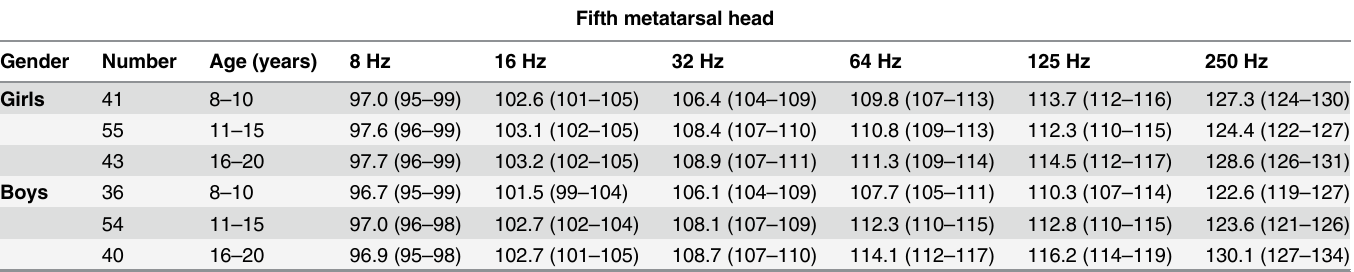
Table 4. Vibration perception thresholds at the fifth metatarsal in the sole of the foot at different frequencies in 269 healthy girls and boys. Fifth metatarsal